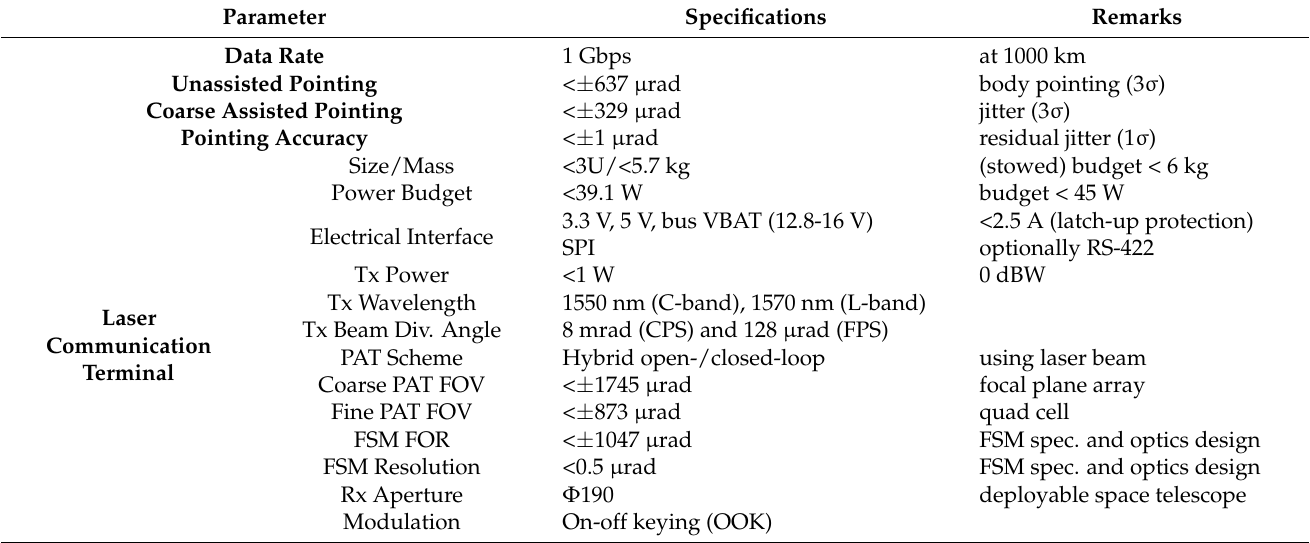
Table 6. Payload design